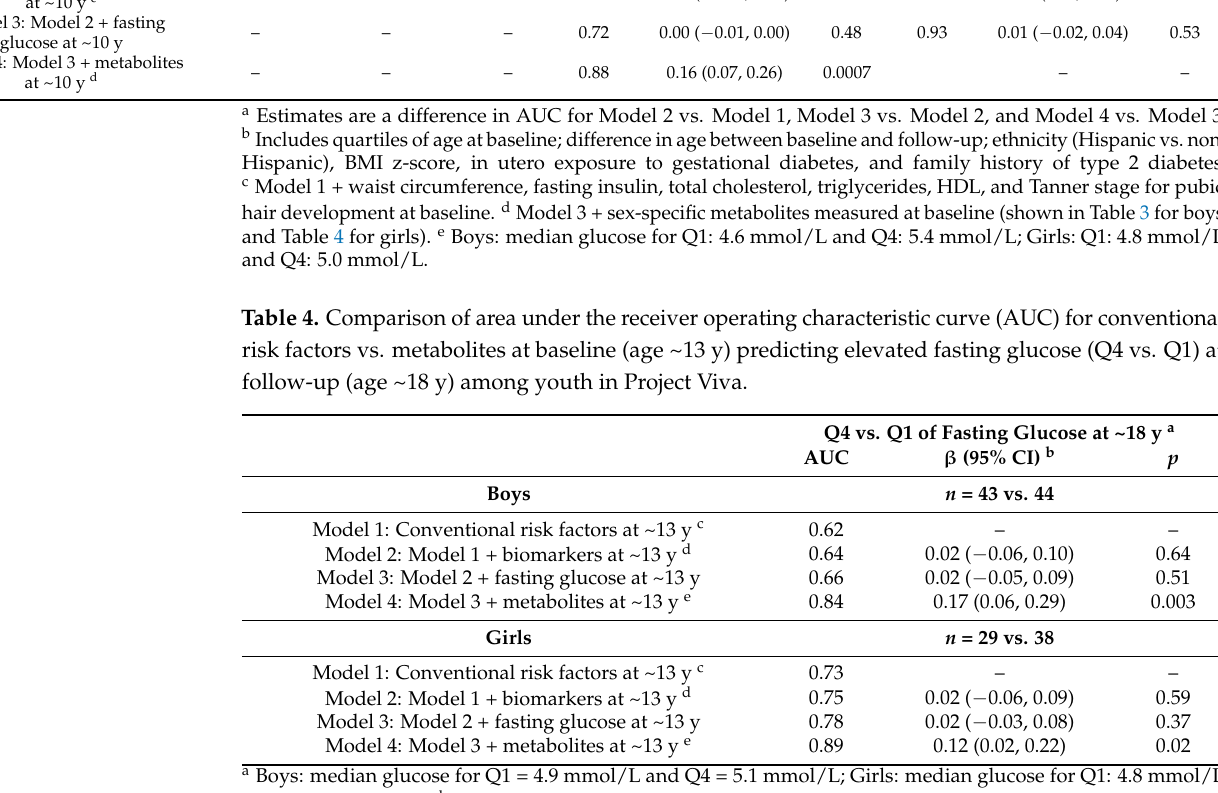
metabolites measured at baseline (shown in Table S3 for boys except for 2 (cid:48) -deoxyuridine and in Table S4 for girls). In girls, we did not have enough cases of IFG ( n = 6) or dysglycemia ( n = 9) to compare across all models, but we observed similar results to that for boys for EFG (Table 3). Excluding seven participants with IFG at baseline did not change the results (data not shown; available upon request), so we included all participants in the final